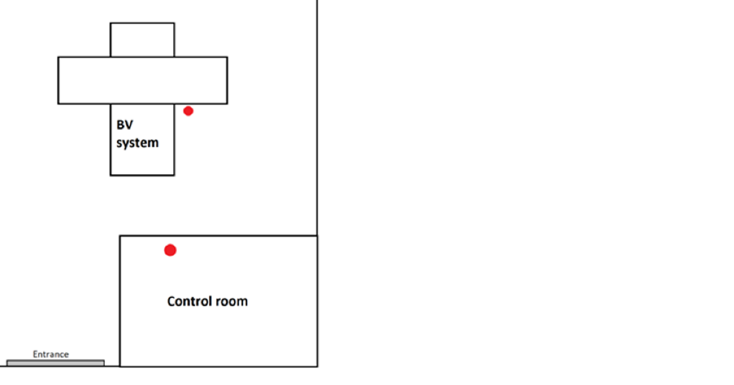
Figure 3. Schematic drawing of Philips BrightView acquisition room with detectors’ locations (red circles).